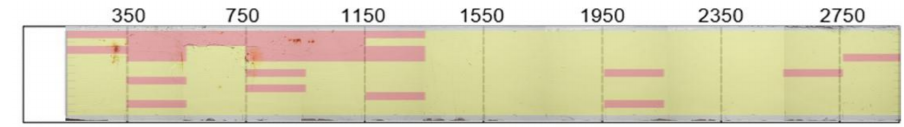
Figure 11. Damage detection with 10 training points, 20 hidden layer neurons, and 100